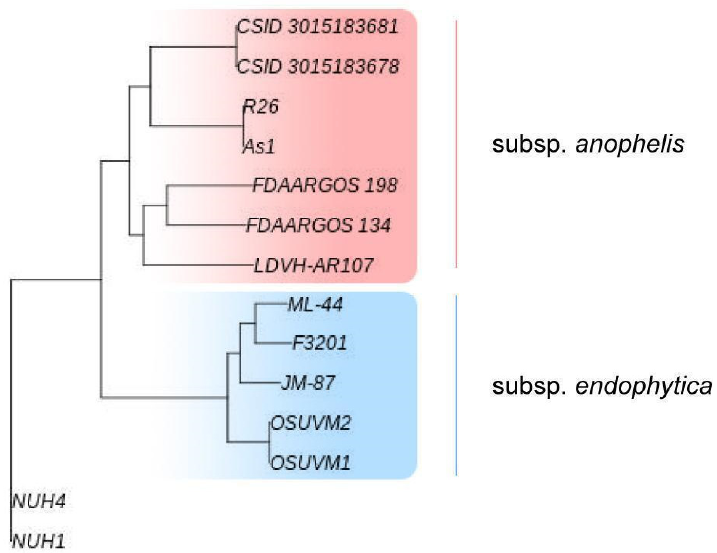
Figure 2. Reconstruction of the whole-genome tree formed by 14 Elizabethkingia anophelis strains. The subsp. anophelis clade is highlighted in red and the subsp. endophytica clade is highlighted in blue.